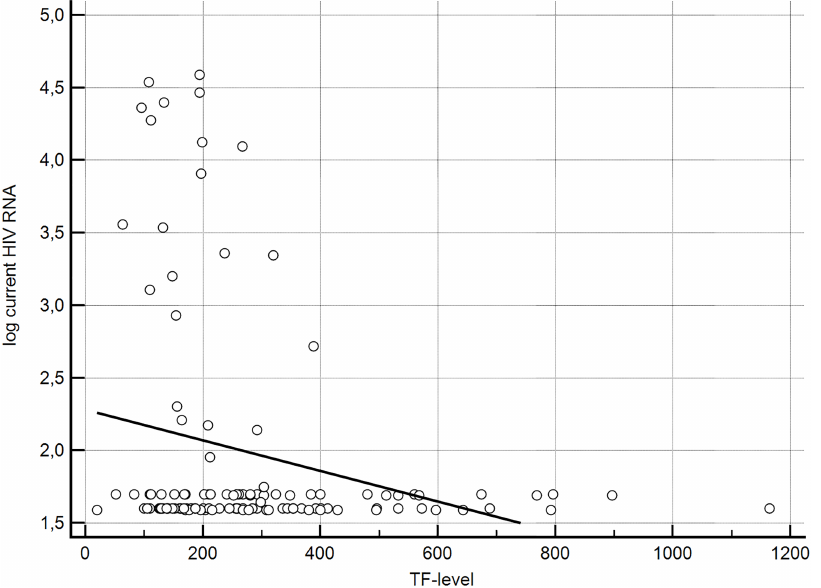
Fig 3. Graphic presentation of the dependency of TF level and HIV RNA